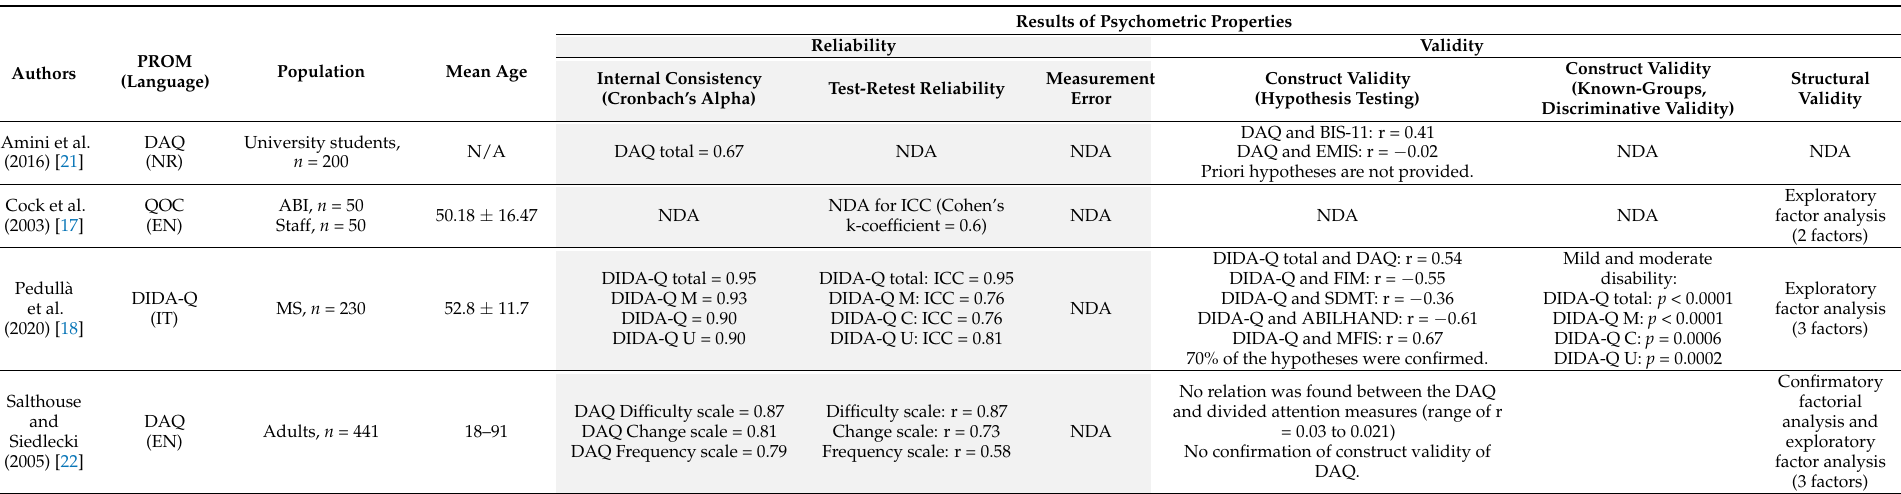
Table 5. Results of studies that assessed psychometric properties of